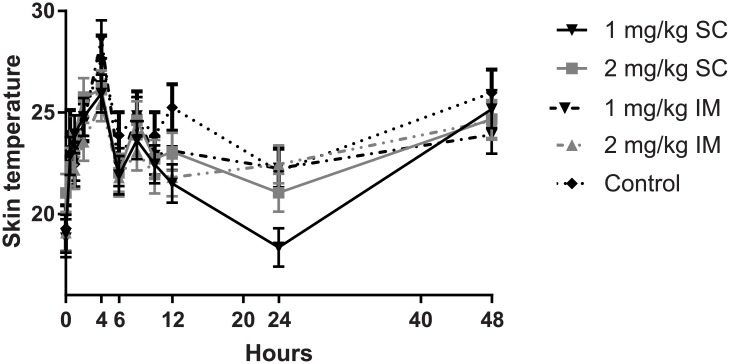
Injected limb skin temperature at selected time-points over 48 h for control group and all four meloxicam treatment groups.There was a significant change in skin temperature between 4 to 6 h (P < 0.005). Treatment effects were seen at 12 and 24 h. The 1.0 mg/kg SC and 2.0 mg/kg IM treatments were significantly less than controls at 12 h (P < 0.05). At 24 h, the 1.0 mg/kg SC treatment was significantly lower than all other treatments and controls (P < 0.05).